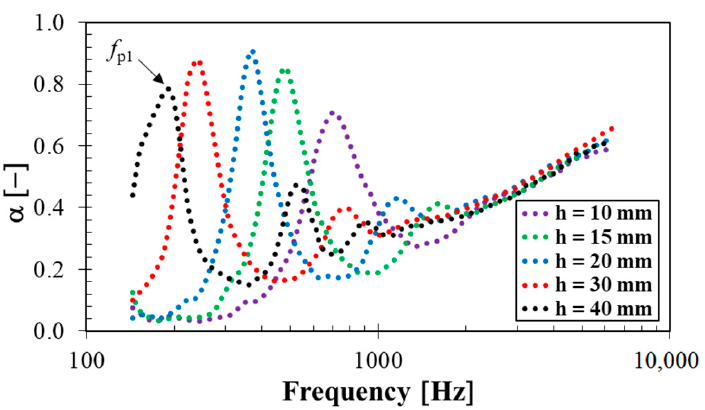
Figure 8. Frequency dependencies of the sound absorption coefficient of the silica powder for different loose powder bed heights. Table 5. Results of measured and calculated acoustical and mechanical quantities for different loose powder bed heights of the applied silica filler.